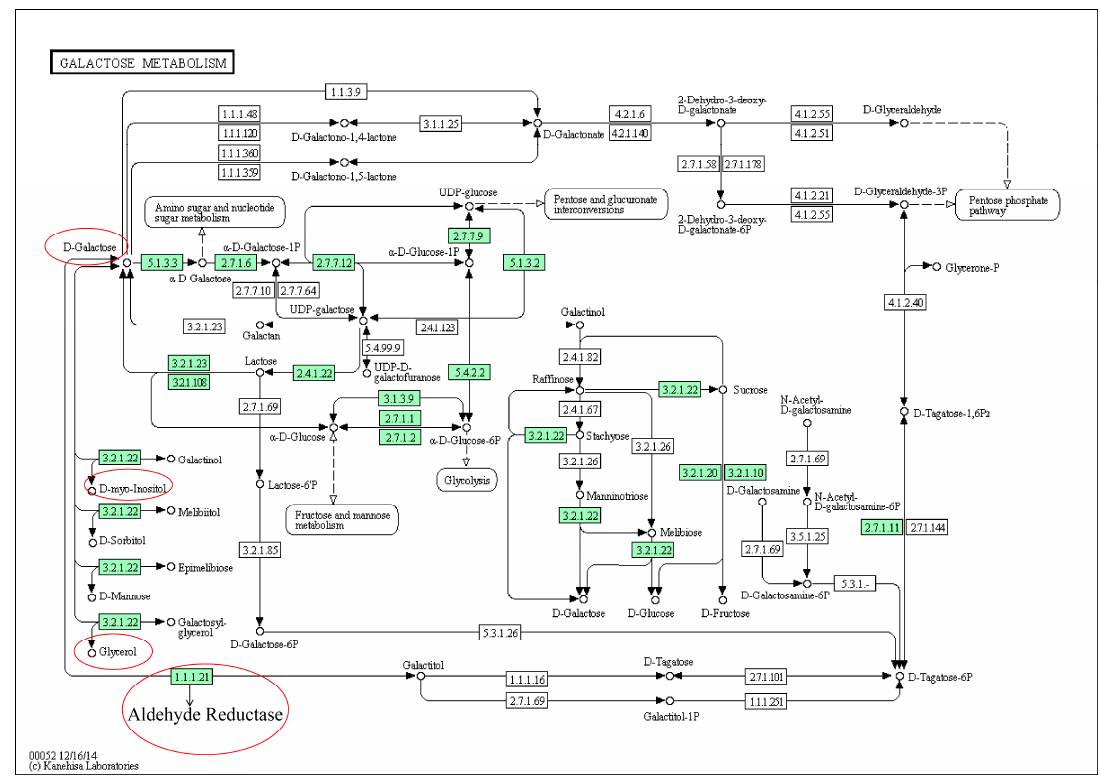
Figure 8. Construction of the galactose metabolism. The map was generated using the reference map by KEGG (http://www.genome.jp/kegg/).